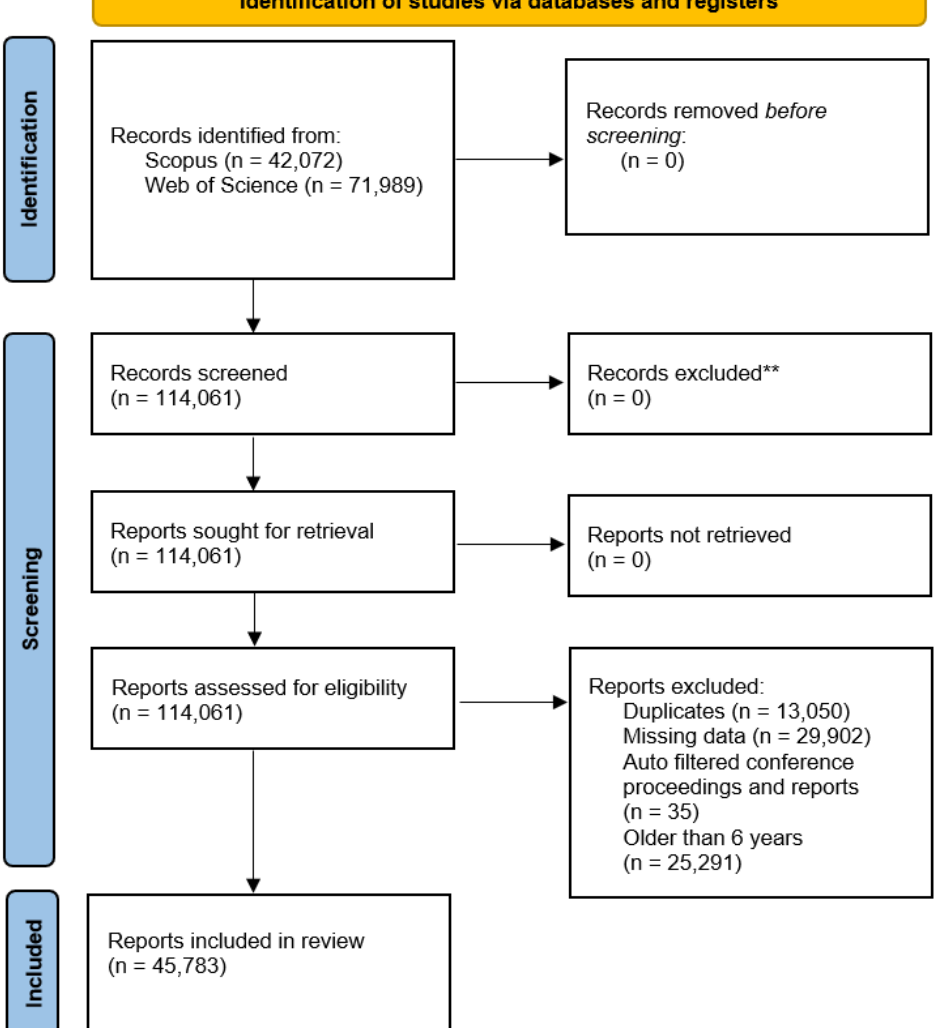
Figure 1. PRISMA flow diagram of dataset curation. ** Count includes exclusions by both humans and automated